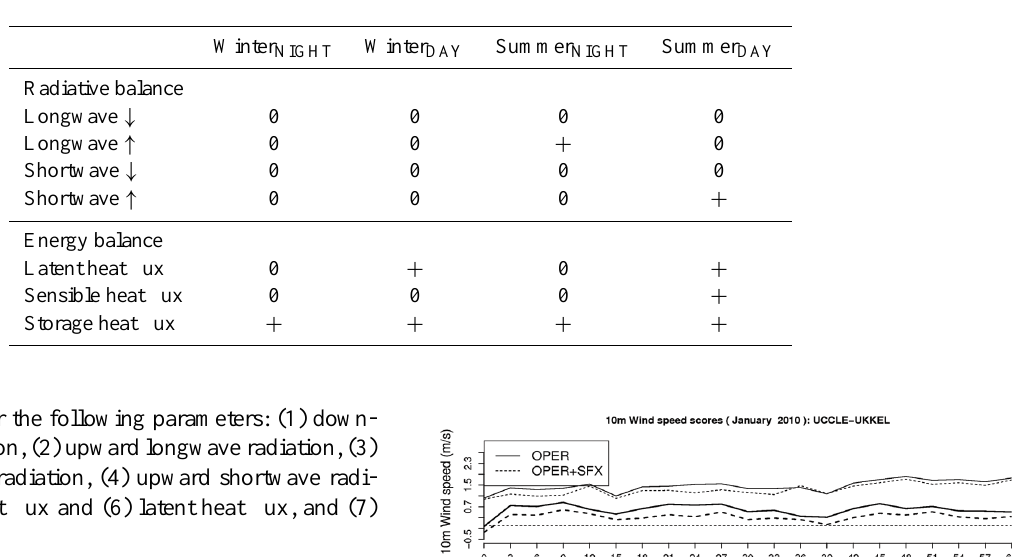
Table 5. The average daytime/night-time scores for the radiative balance, energy balance at the Cabauw tower station. The + sign means improvement, 0 means neutral effect and the − sign means degradation of the scores.